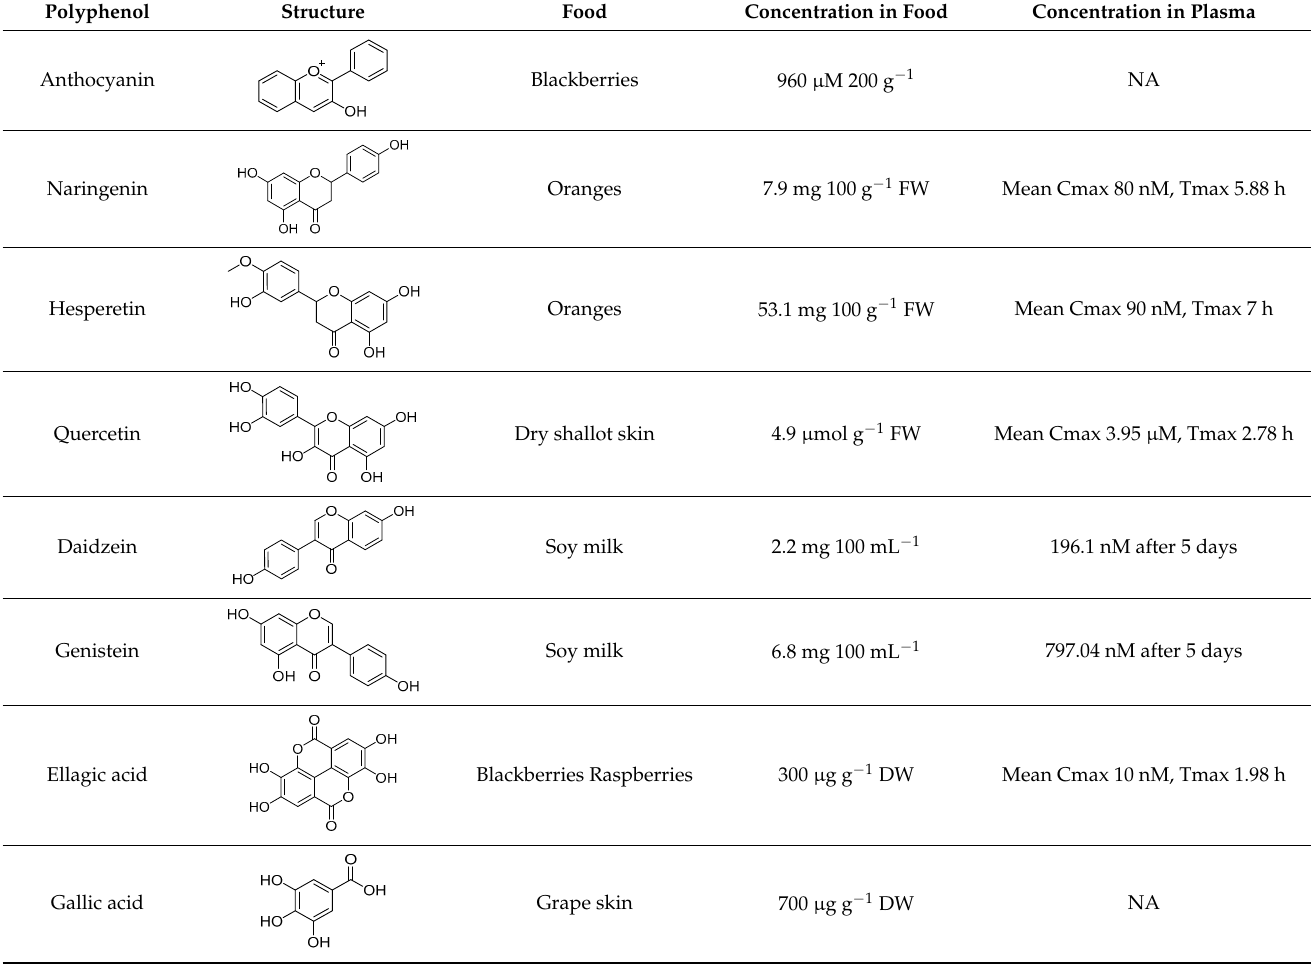
Table 3. Bioavailability in human of some natural polyphenols (Adapted from [95]).